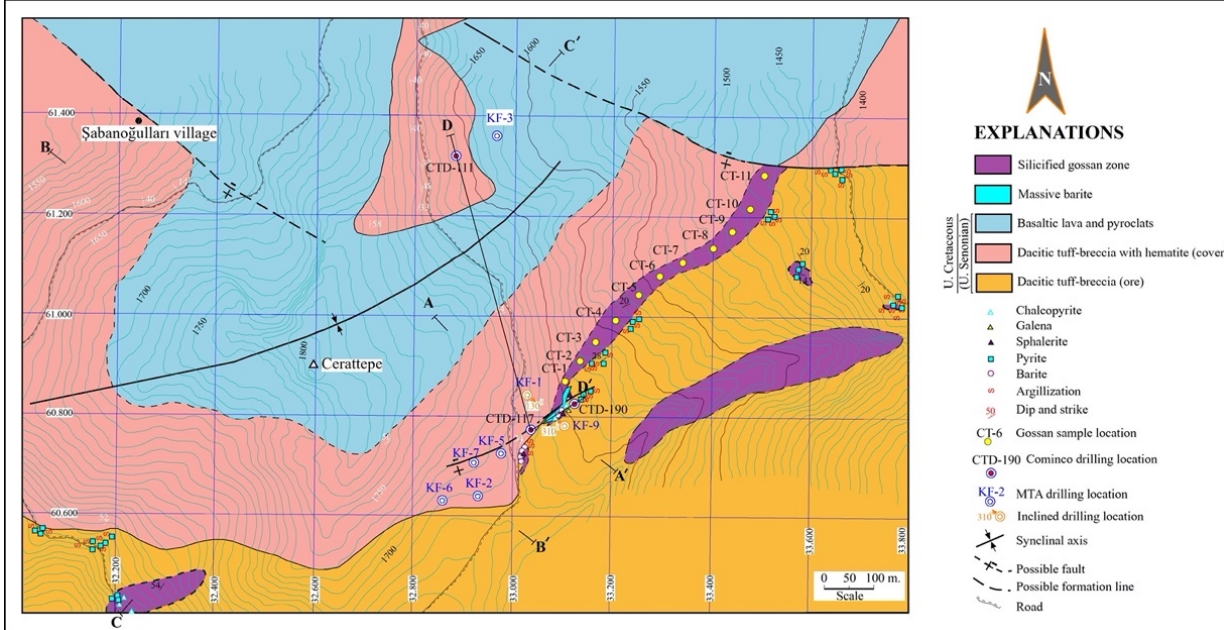
Figure 3. Geological map of the Cerattepe-Artvin area, modified after